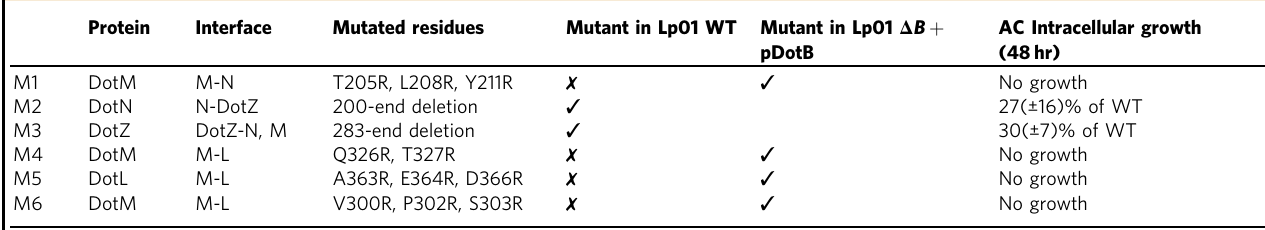
Six mutants (M1 – M6) were generated targeting six different regions (shown in Fig. 4a) of the complex interfaces as described in the main text. Mutants were tested for their ability to grow intra- cellularly in Acanthamoeba castellanii (AC) as described in Methods. Data are presented as mean values + / − standard deviation. Source data are provided as a Source Data fi